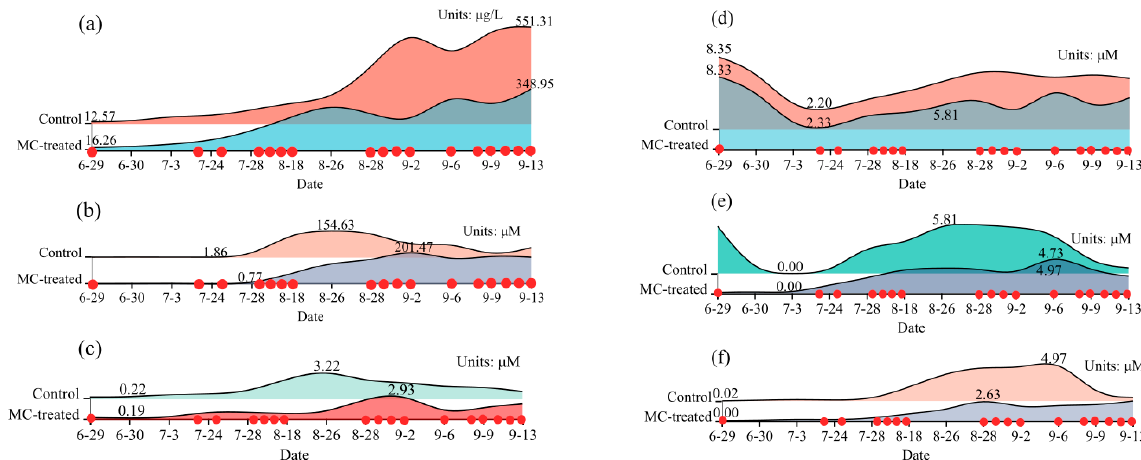
Figure 2. Variation in water quality parameters of the control pond and MC-treated pond through time: ( a ) Chl a , ( b ) TAN, ( c ) PO 43 − -P, ( d ) SiO 32 − -Si, ( e ) NO 3 − -N, ( f ) NO 2 − -N. The red points show the time of MC treatment. The labeled values repre- sent the highest and lowest content.